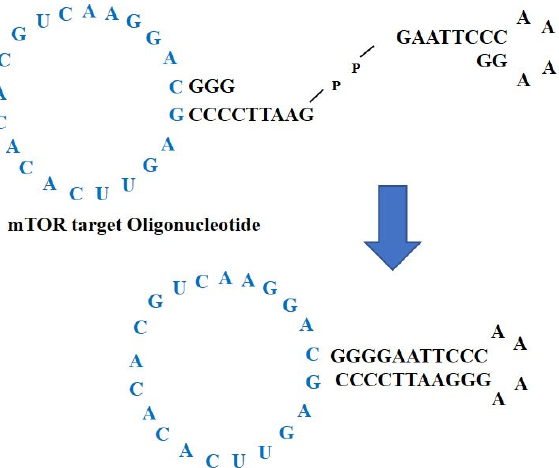
Figure 1. Construction of non-coding RNAs to suppress mTOR translation, mTOR ODNs. The mTOR ODNs have ring-type and double-stranded structures. The ODNs were synthesized by ligating two pieces of ODNs, one of which is mTOR ODNs. The lesion labeled blue is a complementary sequence of mTOR mRNA. ODNs, oligonucleotides; mTOR, mammalian target of rapamycin.